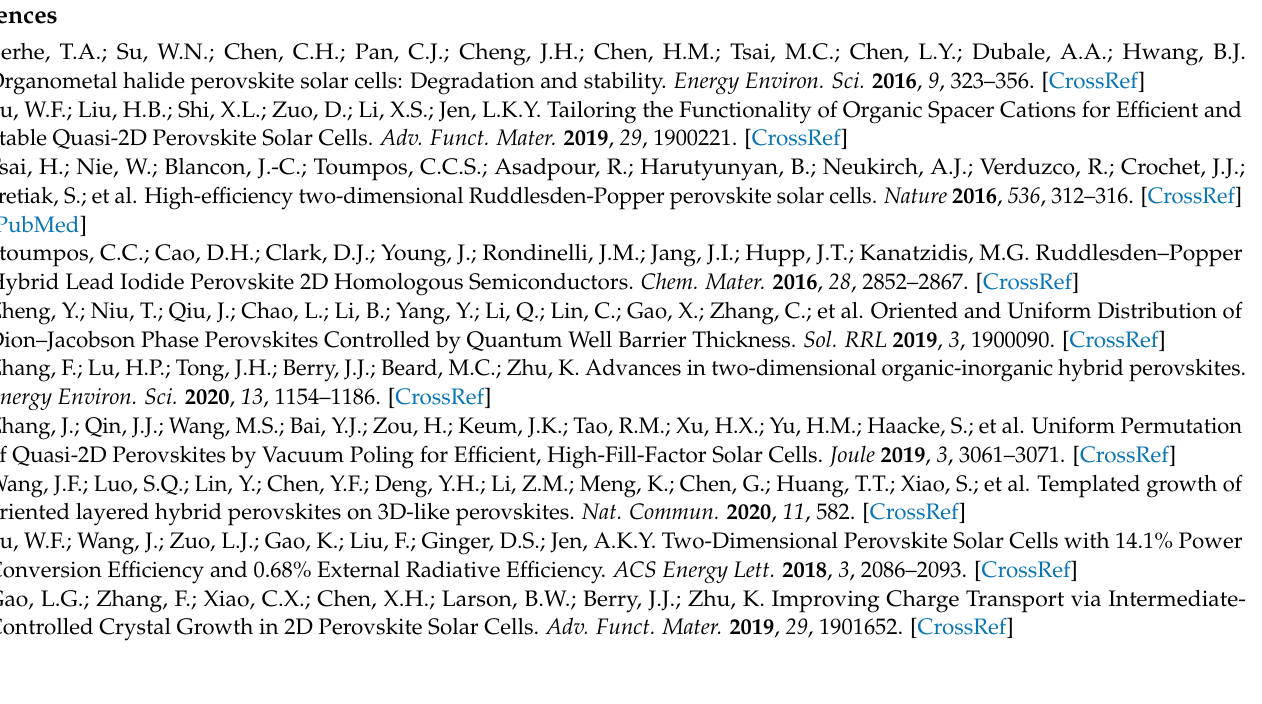
V oc versus light intensity characteristics of devices prepared with different solvents. Figure S4: Normalized TPC curves of devices prepared with different solvents. Figure S5: Optical images for perovskite crystalline growth at different times on a 100 ◦ C hot plate, (a) DMPU; (b) DMSO; (c) DMAC; (d) NMP; (e) GBL. Figure S6: UV–Vis absorption spectra of perovskite films with time variation, (a) DMPU; (b) DMSO; (c) DMAC; (d) NMP; (e) GBL. Table S1: The molecular structural formula and properties of five assistant solvents. Among them, the dielectric constant and Gutmann’s donor number represent the polarity and the Lewis basicity of solvents, respectively. Table S2: Carrier recombination resistance (R rec ) and the trap state density (N t ) in devices based on different assistant solvents. Table S3: Single exponential fitting parameters of TPC and TPV decays of devices prepared with different